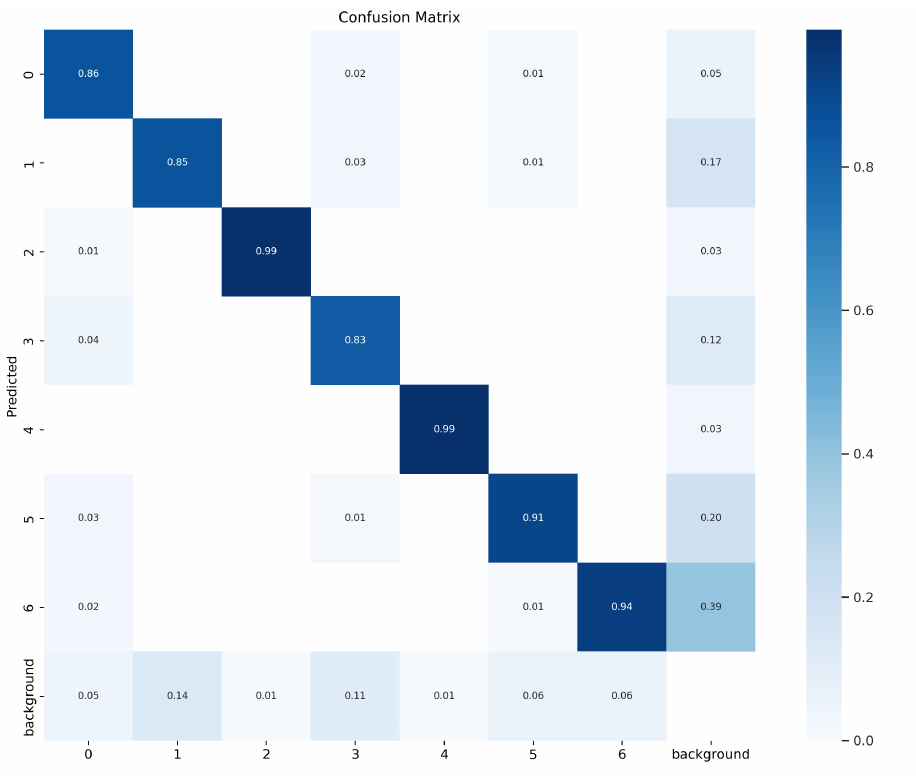
Figure 9. Confusion matrix for YOLOV5 on validation